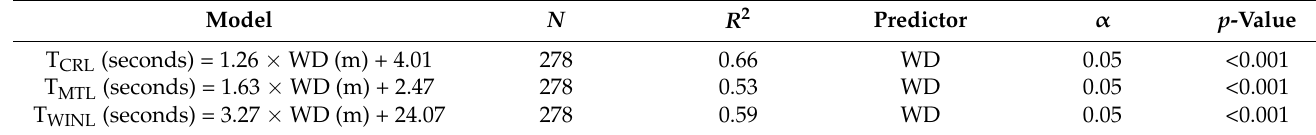
Table 5. Predictive models of time consumption for log-based